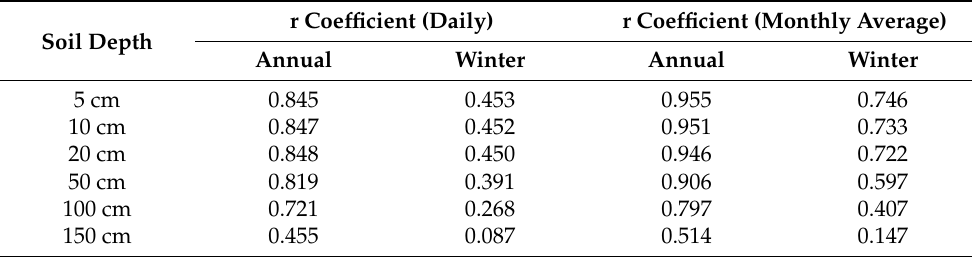
Table 2. Pearson r correlation (r) between air temperature at 2 m and soil